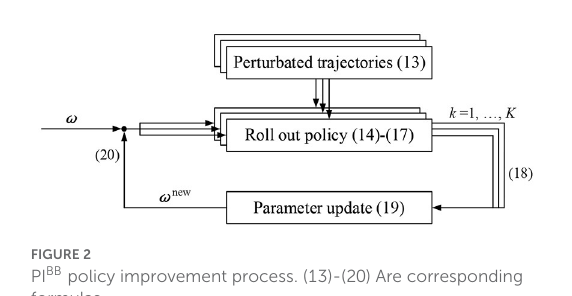
FIGURE2 PI BB policy improvement process. (13)-(20) Are corresponding